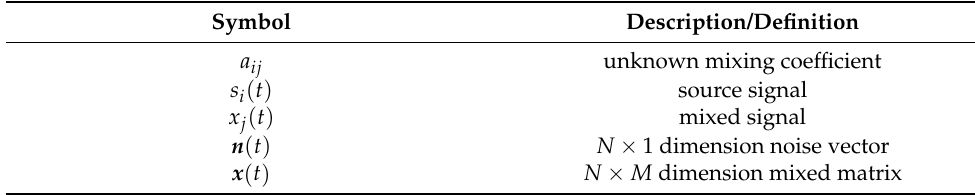
Table 1. Symbols and their brief description/definition in Section 2. Symbol